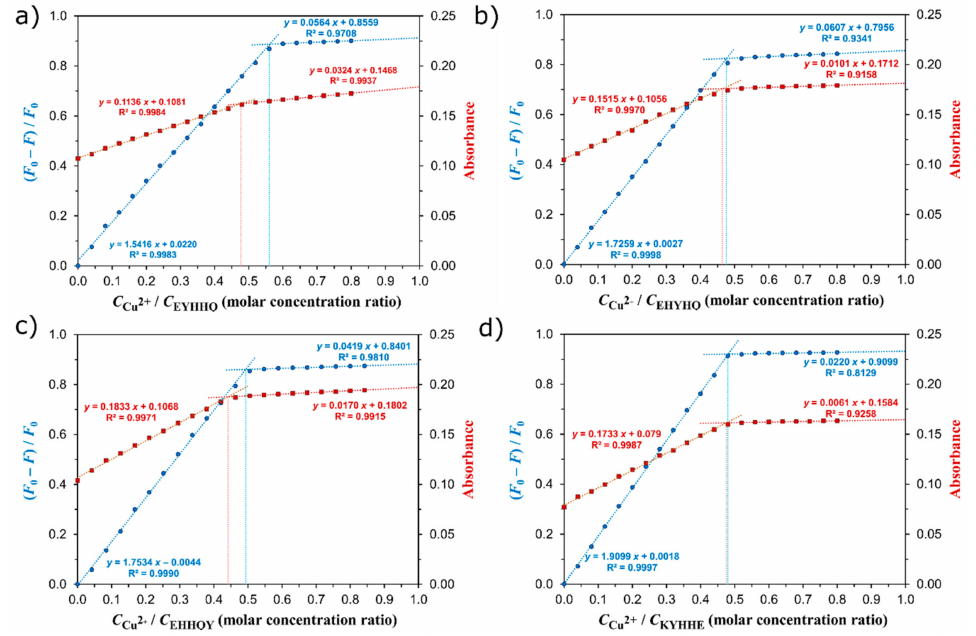
− F Figure 3. The plots of F 0 (blue) and absorbance measured at 275 nm (red) against the metal ion F 0 (cid:18) (cid:19) c Cu2 + to peptide molar concentration ratio for EYHHQ ( a ), EHYHQ ( b ), EHHQY ( c ), and KYHHE c peptide ( d ); c peptide = 0.1 mM: Line–line intersections represent the stoichiometry of the formed Cu 2 + -peptide complexes. F 0 is fluorescence intensity (measured at 305 nm, λ ex = 275 nm) of the peptide in the absence of Cu 2 + ions; F is fluorescence intensity (measured at 305 nm, λ ex = 275 nm) of the peptide at any given concentration of Cu 2 +